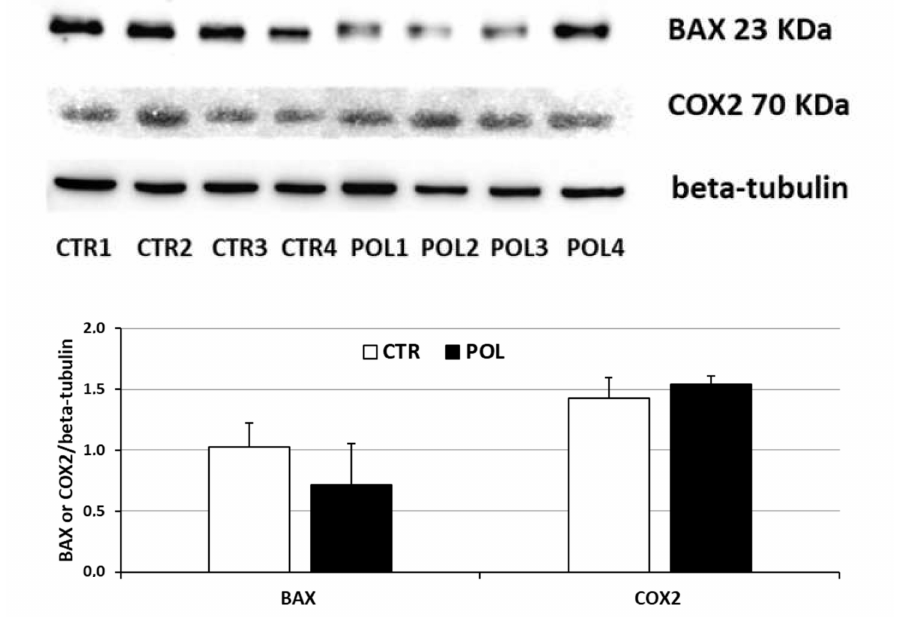
Figure 3. Upper panel: representative immunoblots of BAX, COX2 and beta-tubulin proteins in the ovary of rabbits fed with a commercial pellet alone (CTR) or supplemented with an olive mill waste water product (phenolic content of 282.4 mg/kg: POL); doublet bands at approximately 23 KDa were detected for BAX, a strong band at 70 KDa was detected for COX2. Lower panel: densitometric analyses of the BAX and COX2 blots are reported in arbitrary units relative to beta-tubulin. Data represent the mean ± SD of four replicates. Kruskal–Wallis test: BAX: p = 0.1611; COX2: p = 0.2382. Levene’s test: BAX: p = 0.7964; COX2: p = 0.3163.